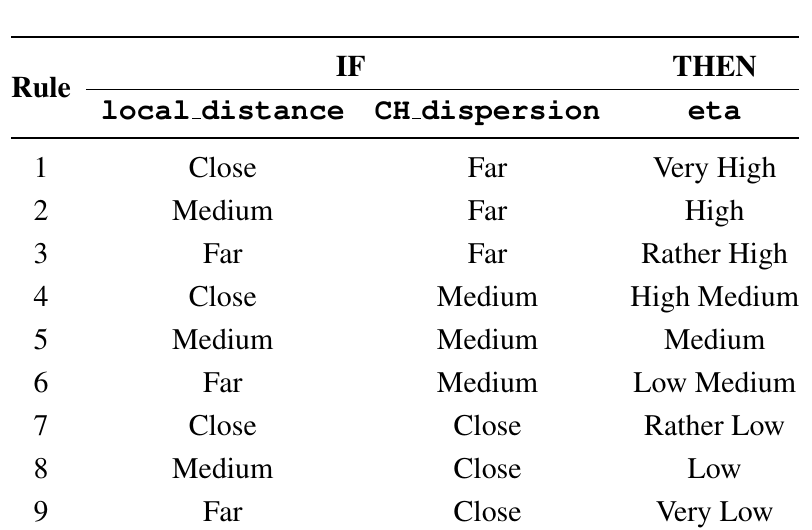
Table 1. Fuzzy rules used in the proposed protocol.